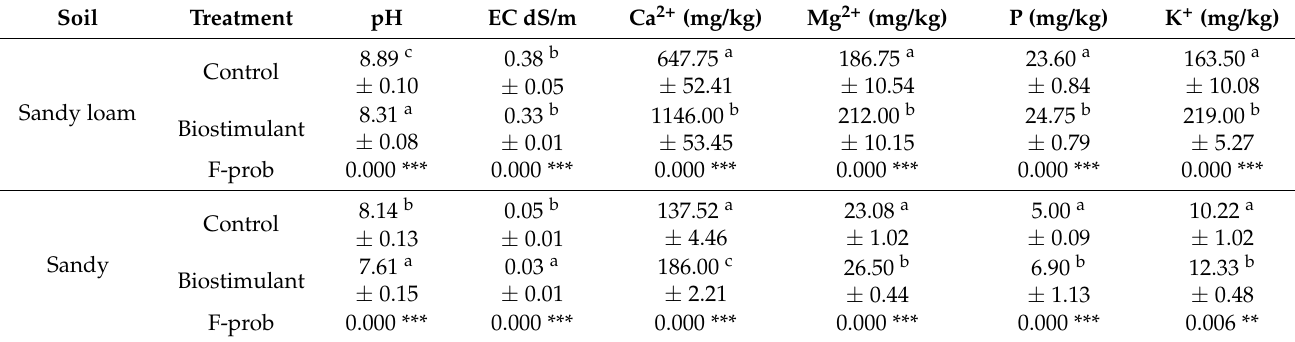
Table 2. Biostimulant effect on soil pH, EC and Ca 2+ , Mg 2+ , K + , and phosphorus ion concentrations in the sandy loam and sandy soils. Means followed by different letters within a column and within a soil type are significantly different ( p < 0.05) according to Tukey’s HSD test. Significance levels (Sig): *** p < 0.001; ** p < 0.010.